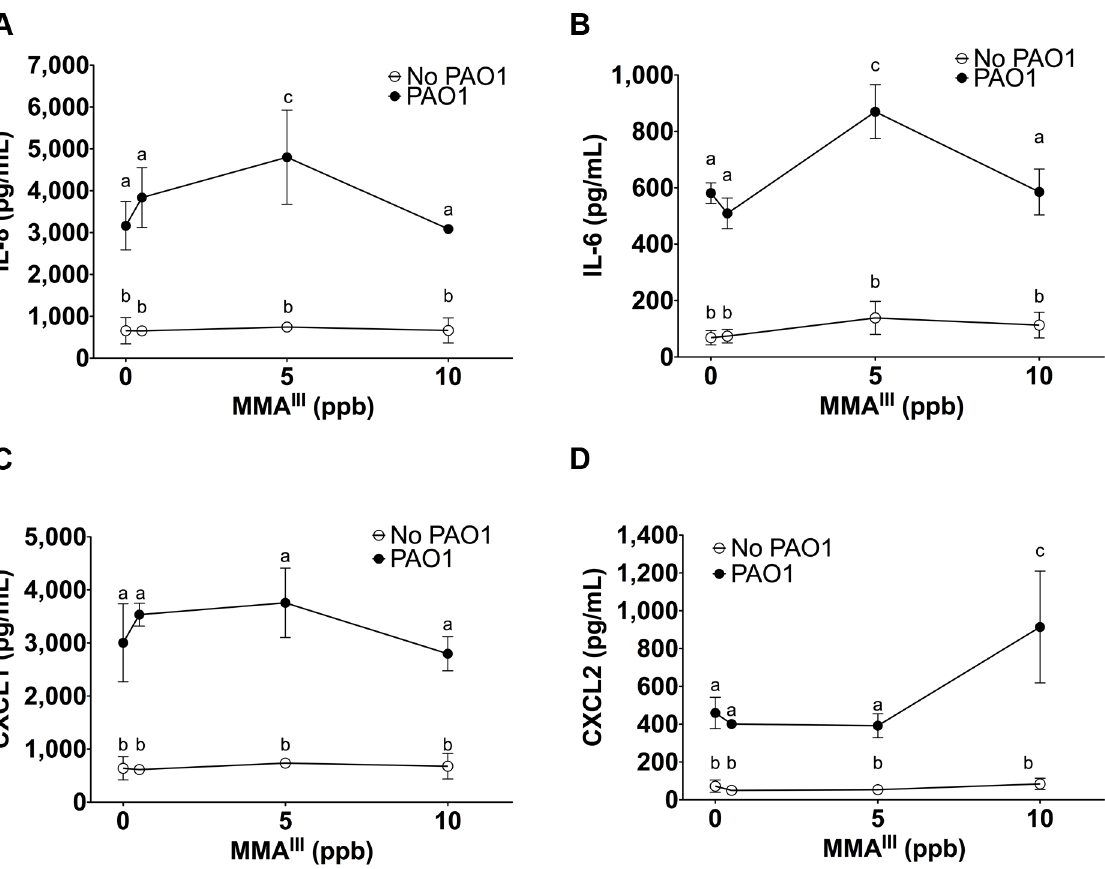
Fig 4. MMA enhances P . aeruginosa induced immune response. Cytokine secretion by HBEC exposed to MMA III ± P . aeruginosa . n = 4 donors for each treatment. Different letters indicate statistically significant treatment means. Data labeled a are not statistically different from each other but are statistically different from data labeled b or c (p < 0.05 as measured by one-way ANOVA). Data with the same letter are not significantly different. (A) IL-8 secretion (B) IL-6 secretion (C) CXCL1 secretion (D) CXCL2